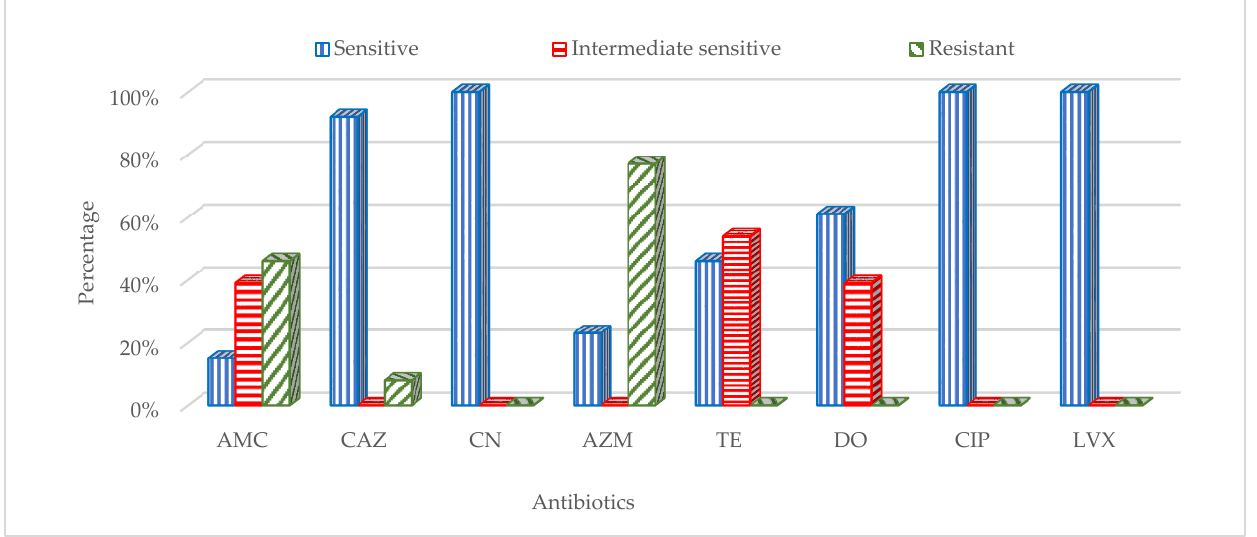
Figure 3. Resistance patterns of Escherichia coli isolates against the following antibiotics: doxycycline (DO, 30 mcg), ceftazidime (CAZ, 30 mcg), gentamicin (CN, 10 mcg), ciprofloxacin (CIP5, 5 mcg), azithromycin (AZM, 15 mcg), amoxicillin/clavulanic acid (AMC, 30 mcg), levofloxacin (LVX5, 5 mcg) and tetracycline (TE, 30 mcg).